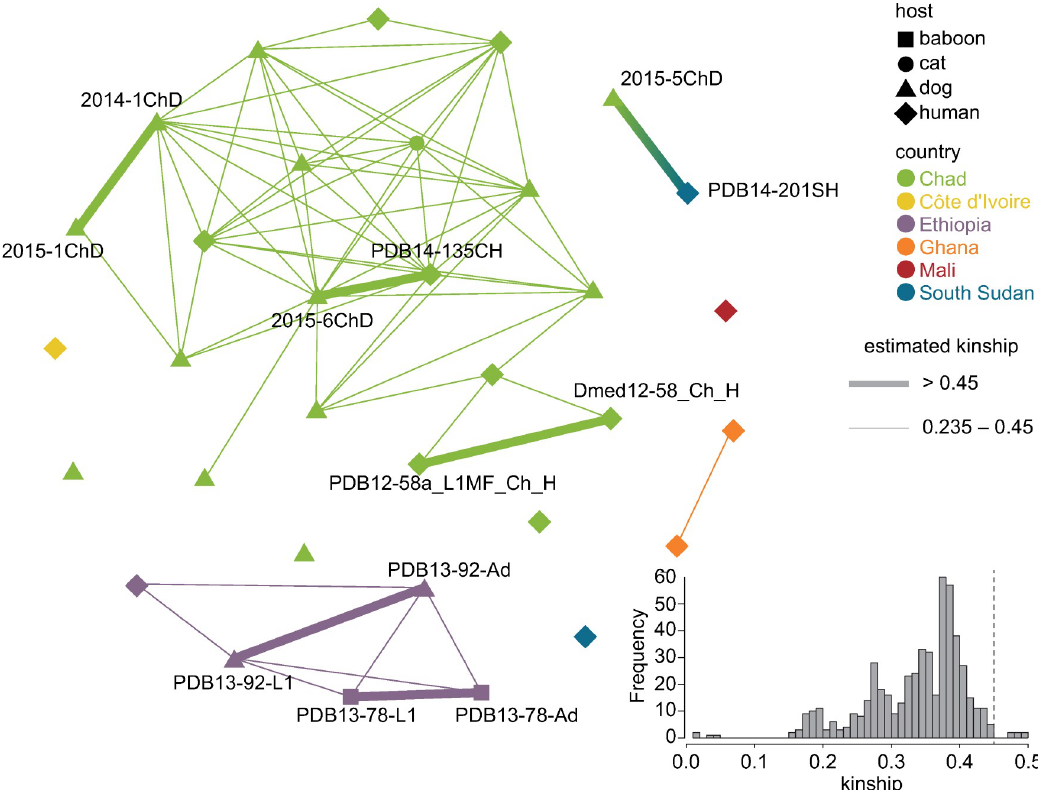
Fig 5. Relatedness between Dracunculus medinensis samples. Nodes on the graph represent worm samples, coloured by their country of origin, and node shapes indicate host species. Lines connect samples with high levels of identity by descent, indicative of direct relatedness. Thick lines indicate kinship > 0.45, whereas thinner lines indicate kinship between 0.45 and 0.235. For clarity, samples with other kinship coefficients are not connected in the graph, and sample names are shown only for those samples in high-relatedness pairs. Inset panel shows the distribution of kinship coefficients across all pairs of